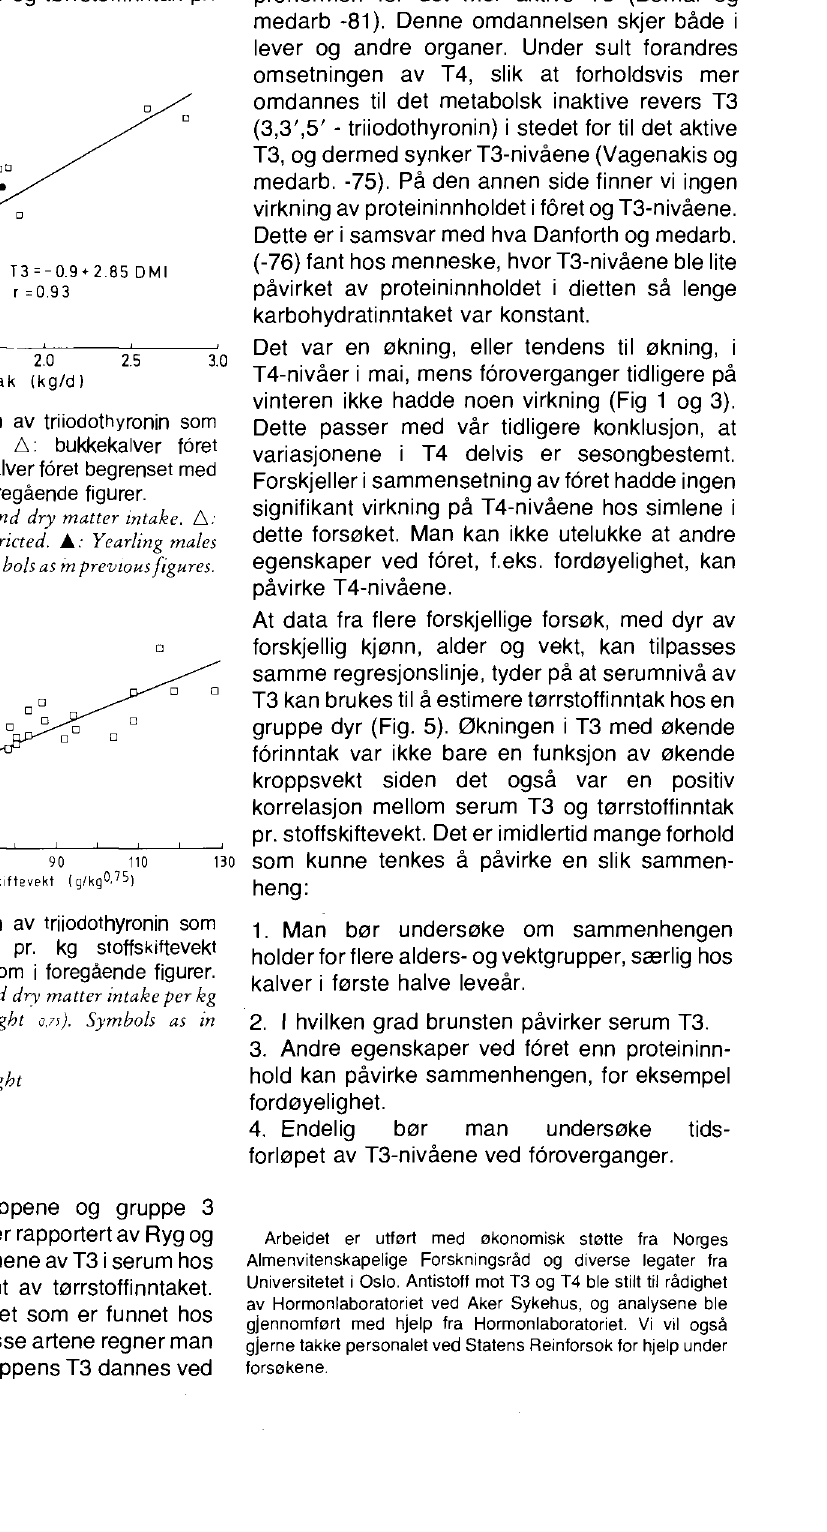
Figur 5. Serumkonsentrasjon av triiodothyronin som funksjon av tørrstoffinntak. A: bukkekalver foret begrenset RF 71. •: bukkekalver foret begrenset med lav. Andre symboler som i foregående figurer. Relations between serum T3 and dry matter intake. A: Yearling males fed RF 71, restricted. A: Yearling males fed lichen, restricted. Other symbols as m previous figures.